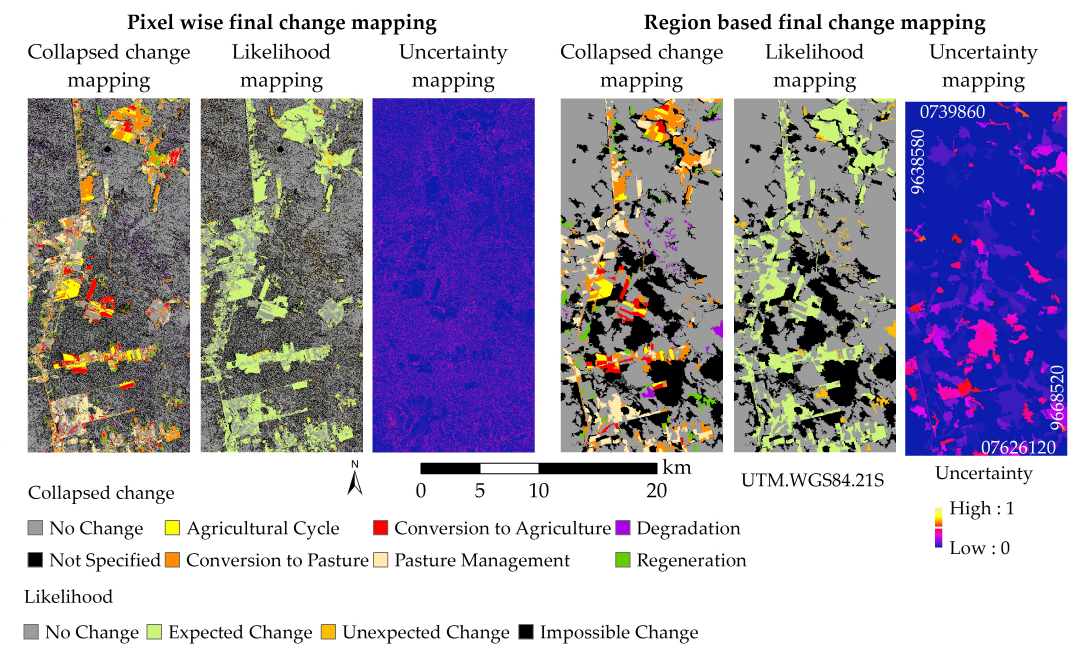
Figure 12. Final change mapping and associated quality mappings for L1 legend.